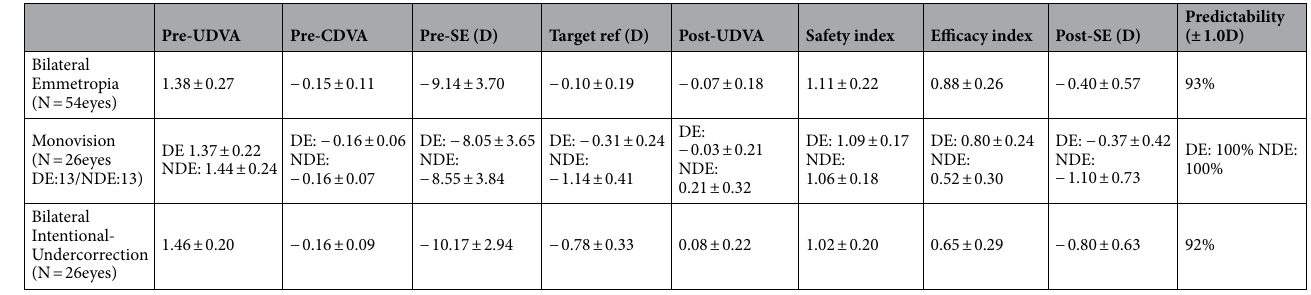
Table 4. Clinical outcomes by target refractive power. UDVA uncorrected distance visual acuity, CDVA corrected distance visual acuity, SE spherical equivalent, DE dominant eye, NDE non-dominant eye.